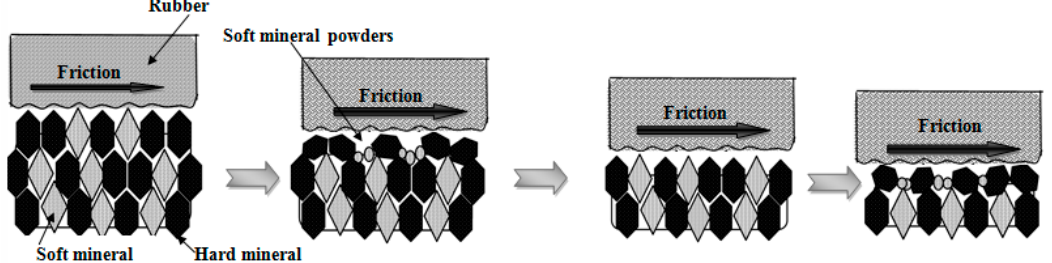
Figure 12. Destruction and recovery of surface microtexture.